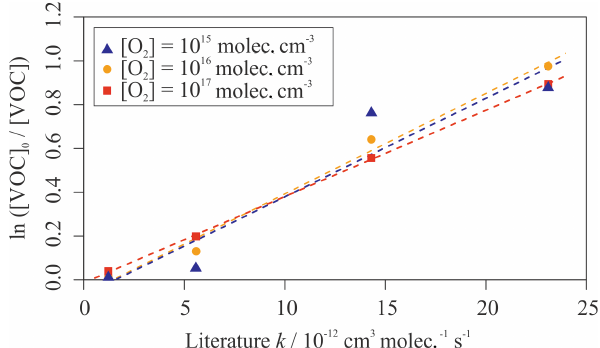
Figure 7. Experimentally derived (data points) and estimated SAR- derived (lines) k values for the reactions between OH and the three diethylbenzene isomers. Data from this work are shown in red.